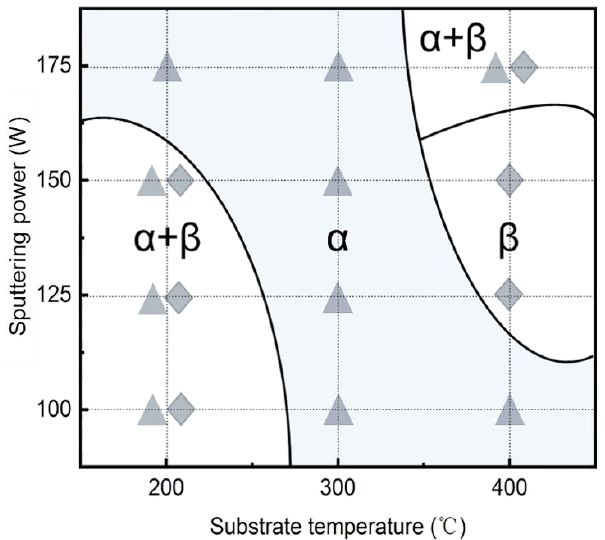
Figure 3. Evolution of phase composition at different T sub and P spu , the α and β were indicated by and , respectively